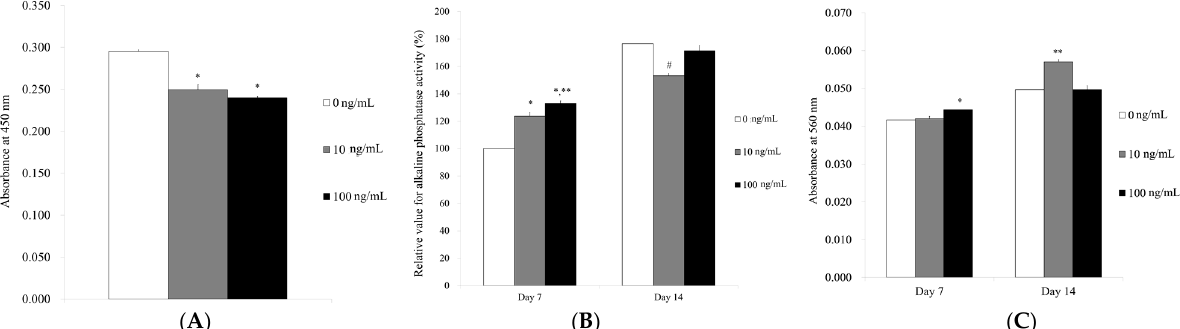
Figure 3. Cellular viability and osteogenic differentiation. ( A ) Cellular viability using a Cell Counting Kit-8 on day 7. * Statistically significant differences were shown when compared with 0 ng/mL ( p < 0.05). ( B ) Alkaline phosphatase activity on days 7 and 14. * Significant increases were noted when compared with 0 ng/mL at day 7 ( p < 0.05). ** Statistically significances were noted when compared with 10 ng/mL at day 7 ( p < 0.05). # Significant differences were seen when compared with 0 ng/mL at day 14 ( p < 0.05). ( C ) Results of Alizarin Red S staining on days 7 and 14. * Significant increases were noted when compared with 0 ng/mL at day 7 ( p < 0.05). ** Statistically significances were noted when compared with 0 ng/mL at day 14 ( p < 0.05).